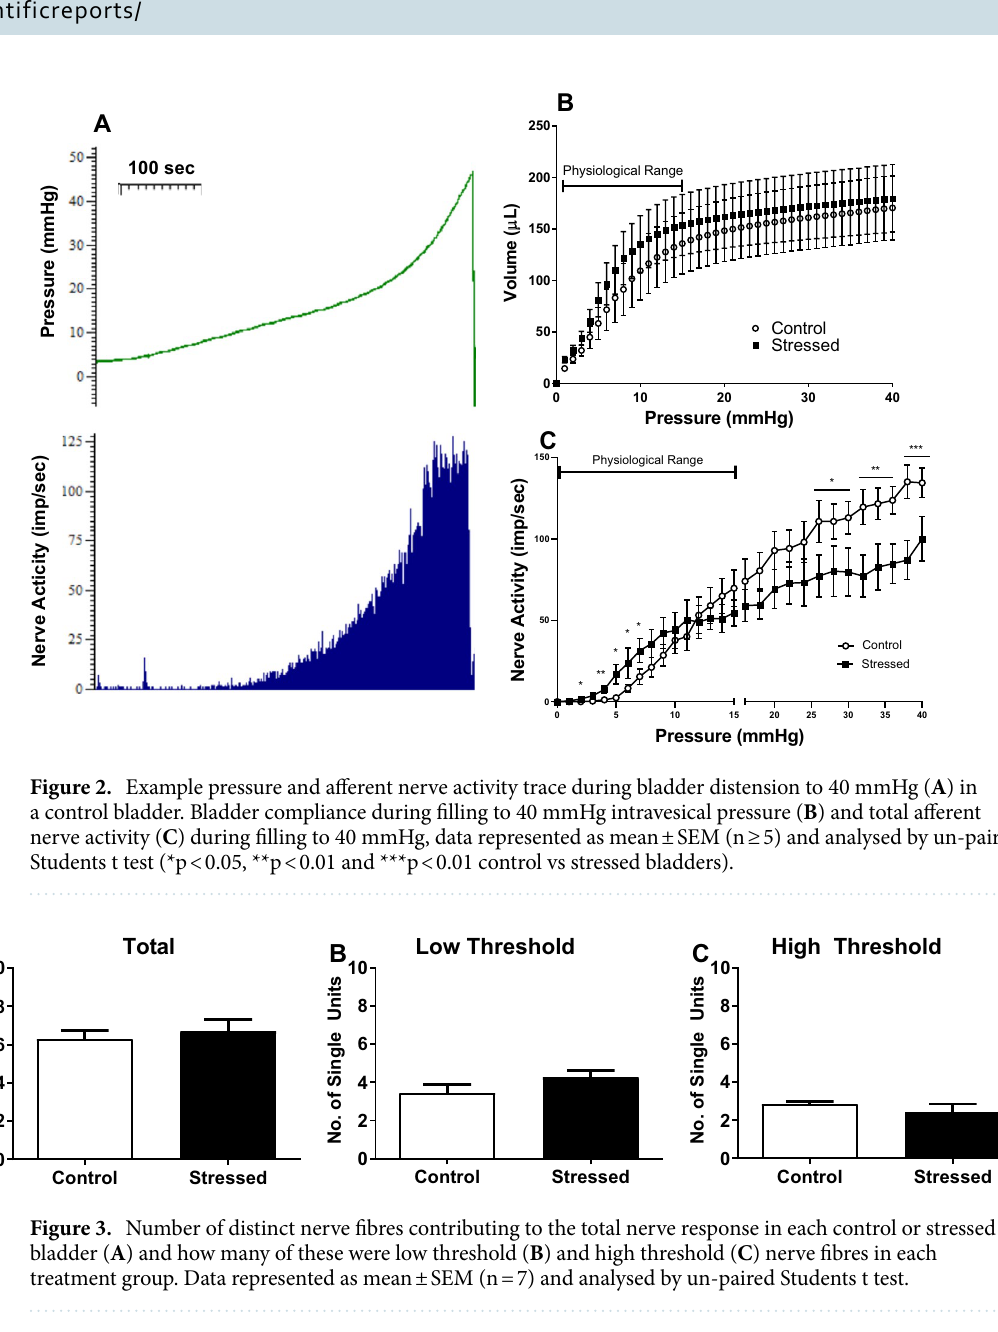
Figure 3. Number of distinct nerve fibres contributing to the total nerve response in each control or stressed bladder ( A ) and how many of these were low threshold ( B ) and high threshold ( C ) nerve fibres in each treatment group. Data represented as mean ± SEM (n = 7) and analysed by un-paired Students t